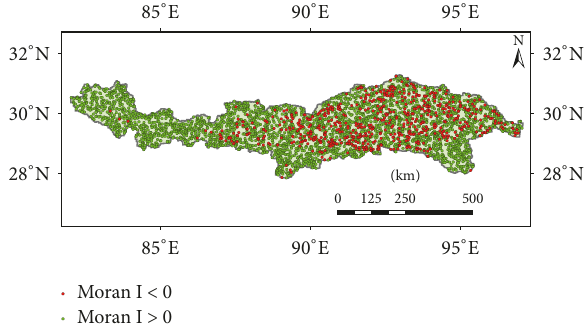
Figure 3: Spatial distribution of NDVI Moran Index values in the Yarlung Zangbo River